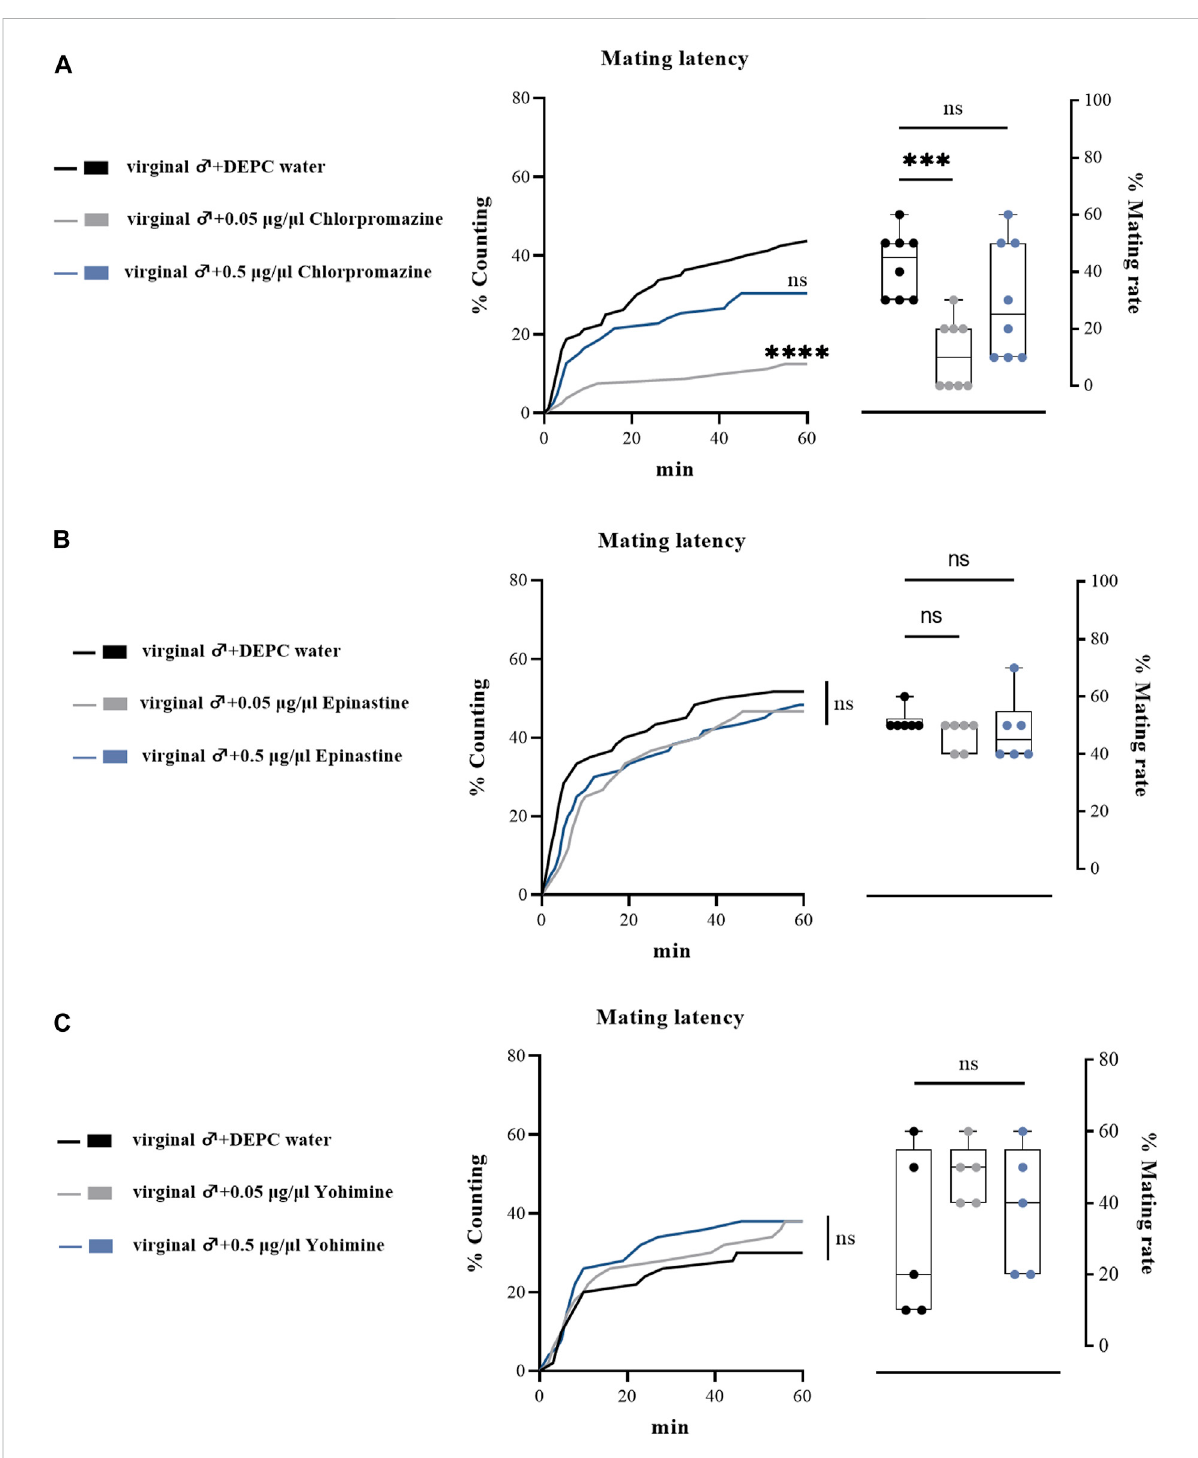
FIGURE 6 Changes in mating latency and mating rates following injection of biogenic amines receptor antagonists in virginal male fl ies. Mating assays were performed at 2 h after injection on virginal male fl ies (13th day post emergence). DEPC water treatment was served as control. For treatment groups, 0.05 μ g/ μ l chlorpromazine (A) , epinastine (B) and yohimine (C) were injected, respectively. Values are the means (± SEs) of replicates. Statistical comparisons were conducted by comparing each treatment with control, respectively, and based on Log-rank (Mantel-Cox) test (mating latency) and Students ’ s t test (mating rate). The level of signi fi cance for the results was set at * p < 0.05, ** p < 0.01, *** p <